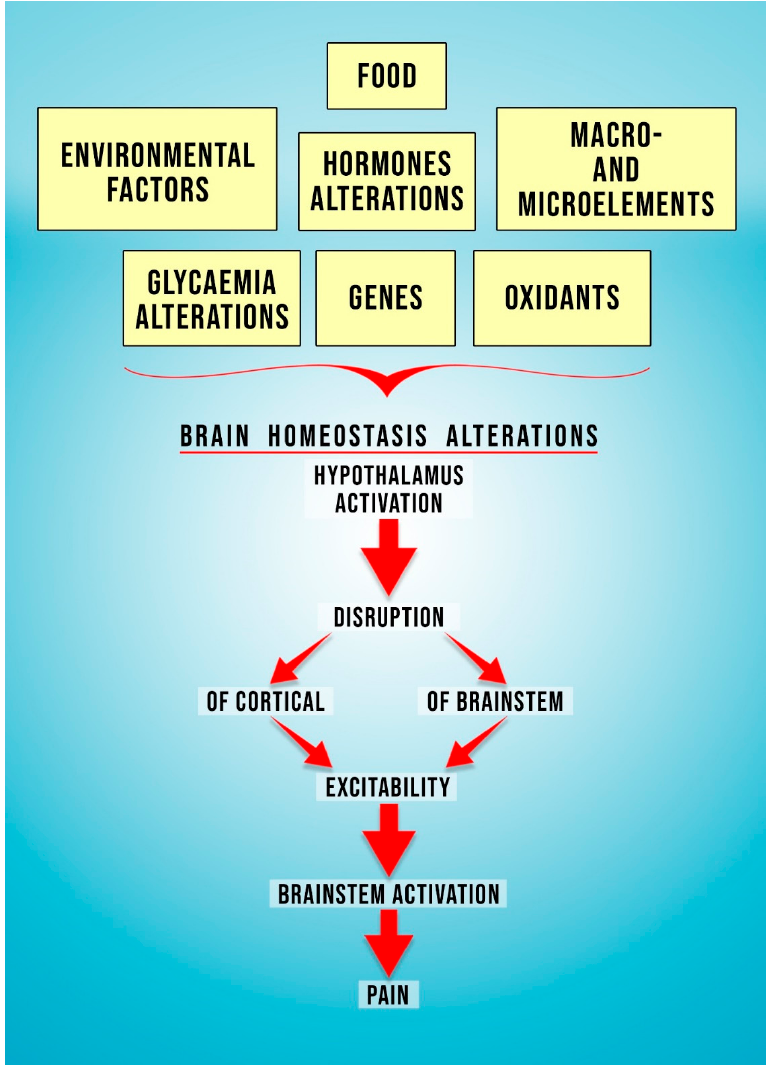
Figure 1. Neurobiological processes leading to migraine pain.